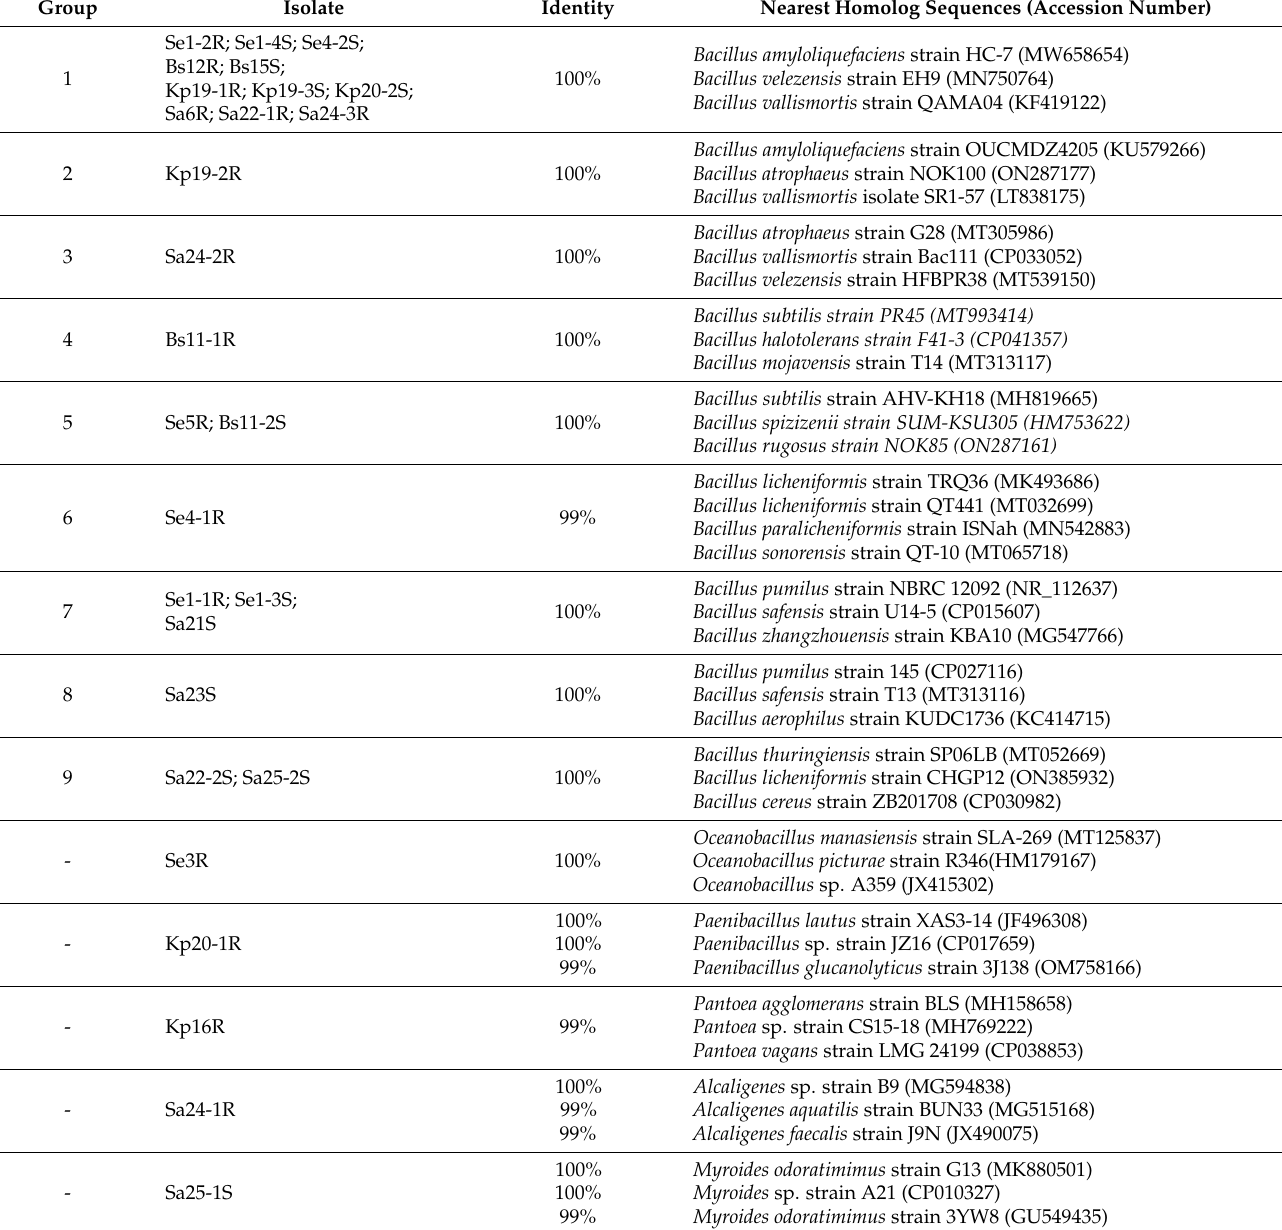
Table 2. Molecular identification of